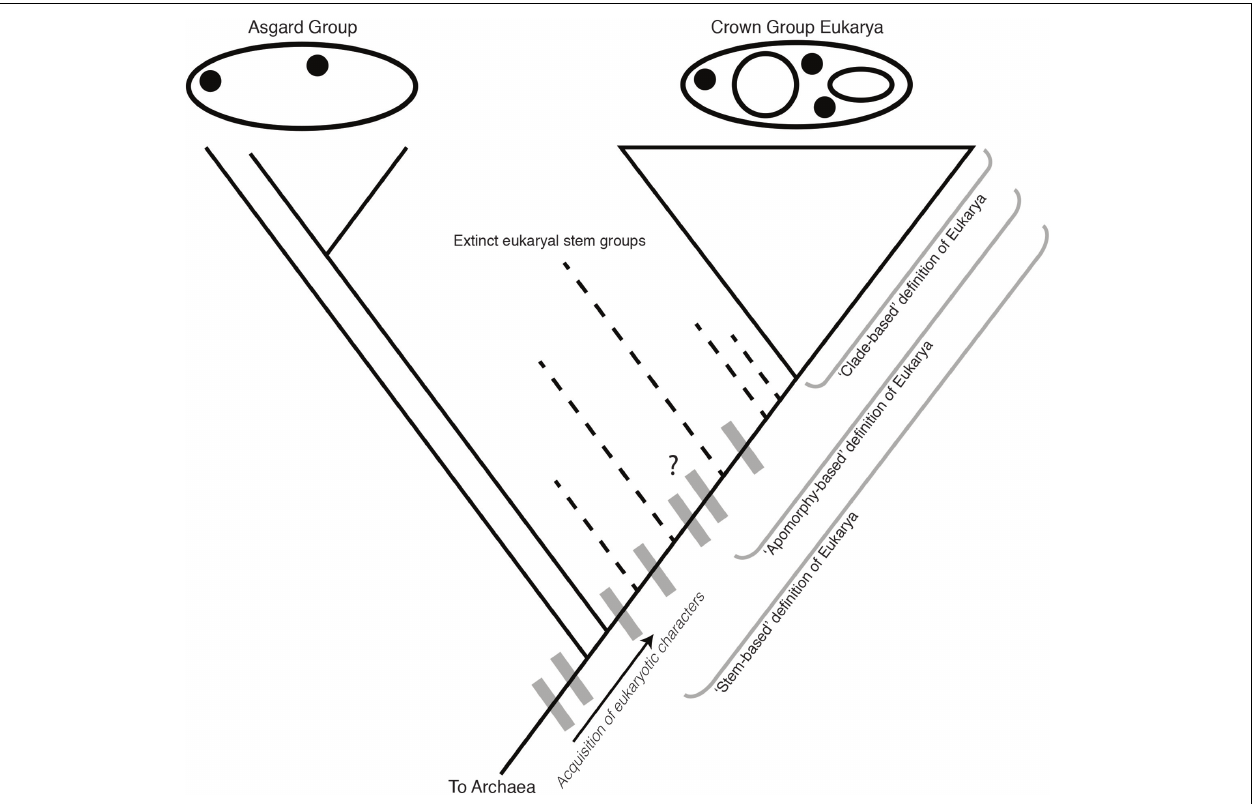
FIGURE 4 | Cladogram of Asgard and eukaryote evolution as related to different definitions of Eukarya. Eukaryal-specific characters (ESPs, gray boxes) were acquired in the ancestor of Asgard + Eukarya, and continue to be acquired in the eukaryal stem lineage. An apomorphy-based definition of Eukarya requires the identification of a specific defining character for Eukarya, which would include some eukaryal stem groups, but exclude others. The selection of a defining character for an apomorphy-based definition is therefore inherently subjective. The Asgard group is depicted as an evolutionary grade, although a monophyletic Asgard group is also consistent with this